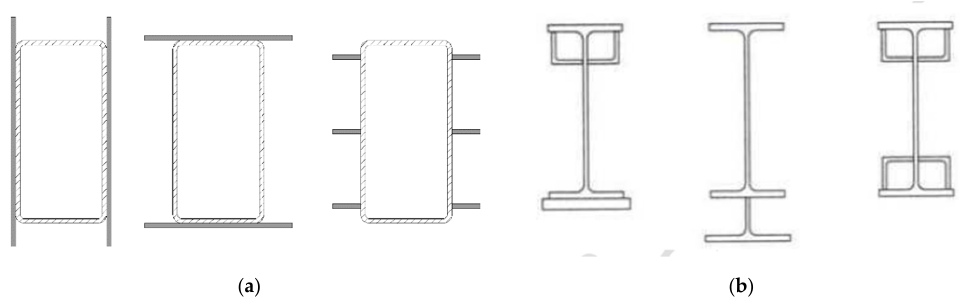
Figure 3. Flowchart of greenhouse assessment methodology. Abbreviations: Ultimate Limit State- ULS, Serviceability Limit States-SLS.